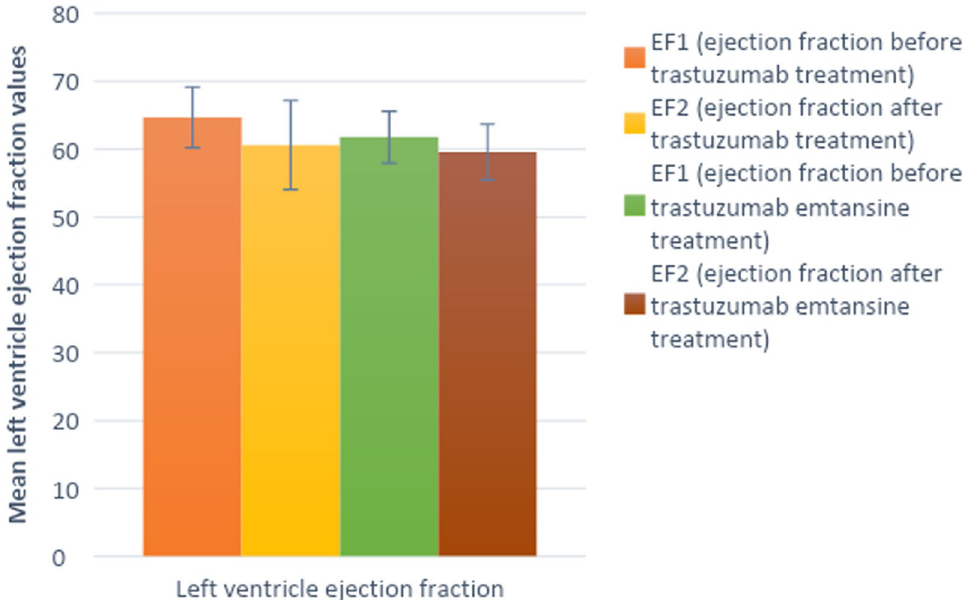
Fig. 2 LVEF values measured before and after both antibody drug protocols ( LVEF1 T Left ventricular ejection fraction before trastuzumab, LVEF2 T Left ventricular ejection fraction after trastuzumab, LVEF1 ET Left ventricular ejection fraction before trastuzumab emtansine, LVEF2 ET Left ventricular ejection fraction after trastuzumab